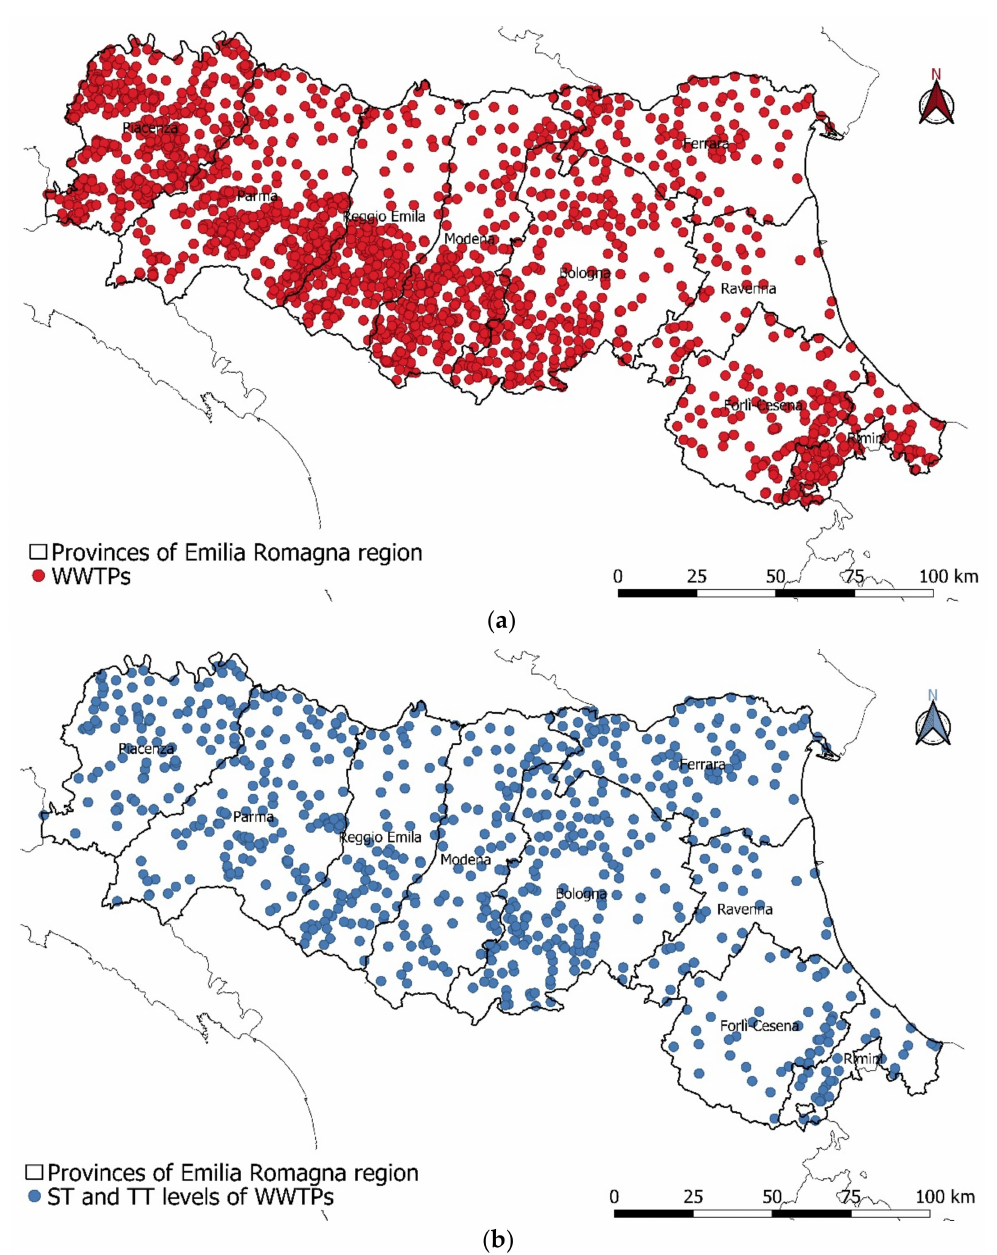
Figure 2. WWTP distribution at the territorial level within the Emilia-Romagna region: ( a ) WWTP localization considering all treatment levels; ( b ) WWTP localization considering only ST and TT